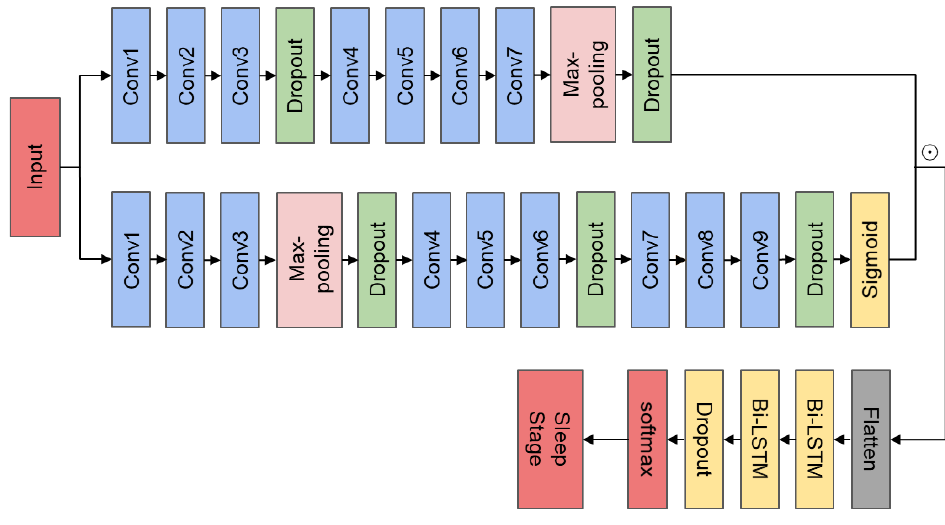
Figure 3. Detailed structure of CAttSleepNet model. Table 1. Detailed parameters of CAttSleepNet